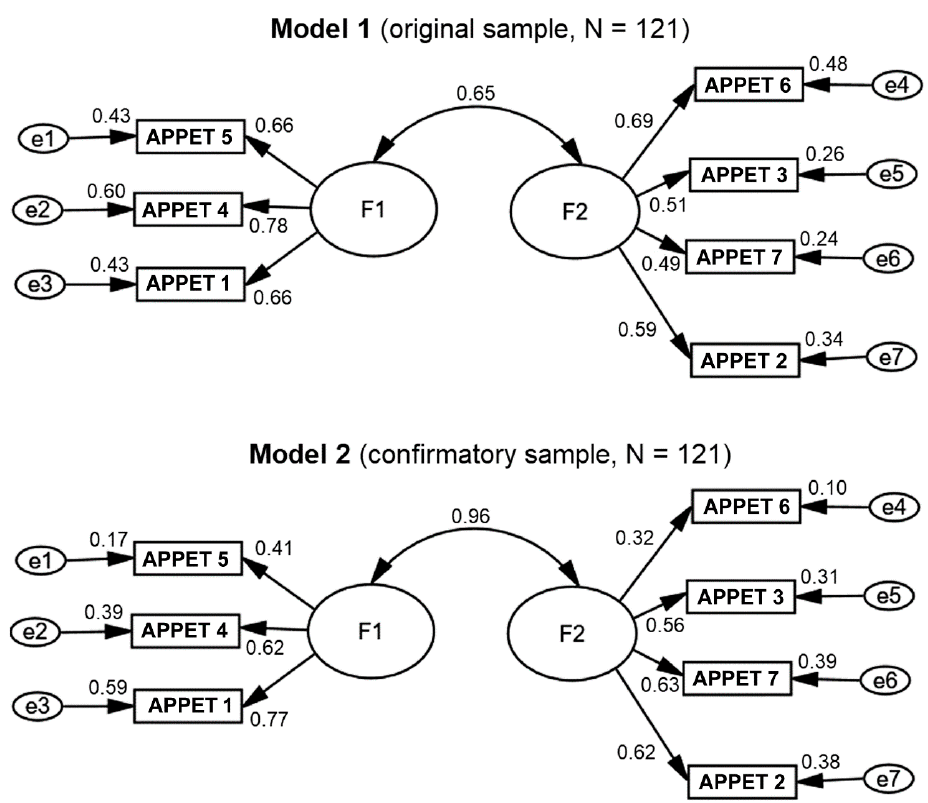
Figure 1. Confirmatory analysis models. F1 = factor 1 (related to the perceived flavor of the food); F2 = factor 2 (related to the perception of gastric fullness). Items: APPET 1 = “My appetite is…”; APPET 2 = “When I eat…”; APPET 3 = “I feel hungry…”; APPET 4 = “Food tastes…”; APPET 5 = “Compared to when I was younger, food tastes…”; APPET 6 = “Normally I eat…”; APPET 7 = “I feel sick or nauseated when I eat…”;. APPET refers to each one of the items of the appetite questionnaire.